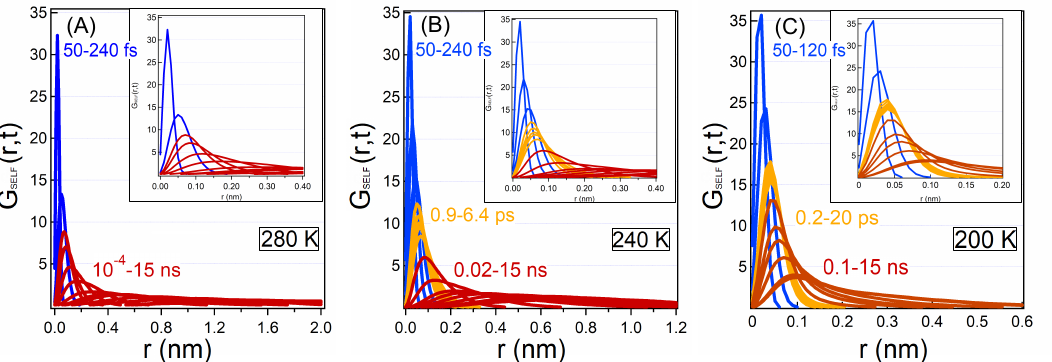
Figure 3. Self van Hove Functions (SVHFs) calculated for three temperatures: T = 280 K (panel A ), 240 K (panel B ) and 200 K (panel C ). The chosen curves evidence the water relaxations focusing in particular on the ballistic behaviour, the caging and the α relaxation of the MCT. Colours are used to point out three different time regimes which characterise the dynamics of the system. At short times (blue curves), the particle moves as a free particle with a ballistic behaviour and it is found for all the temperatures. At intermediate times and sufficiently low temperatures (orange curves), water is trapped in the transient cage, and this phenomenon is already present at T = 240 K and becomes particularly evident at T = 200 K where the transient cage lasts for a long time. In the long time regime (red curves) density fluctuations show the α relaxations process similar to bulk water. This relaxation process is well described by the MCT